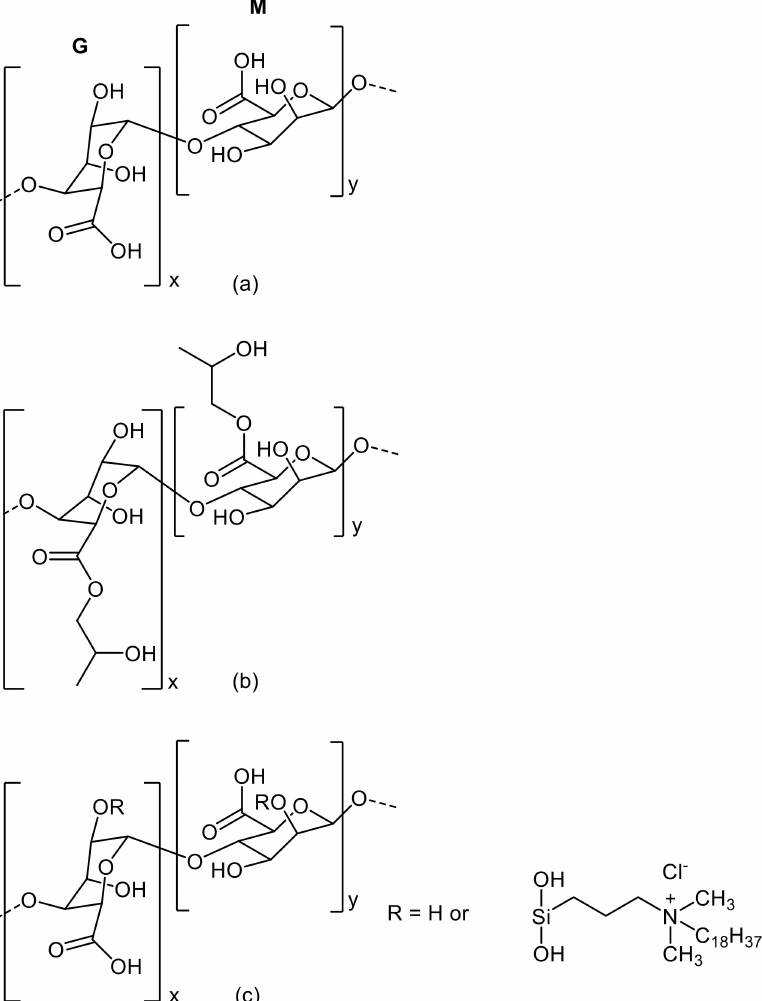
Figure 2. ( a ) Alginic acid block co-polymer containing monomers of β - D -mannuronic acid (M) and α - L -guluronic acid (G) joined by a 1,4-glycosidic linkage. ( b ) Alginic acid esterified with propylene glycol to give propylene glycol alginate (PGA) (esterification (70%) occurs at both the M and G residues. ( c ) Alginic acid reacted with (3-(trimethoxysilyl)propyl)-octadecyldimethylammonium chloride (TSA) to give the corresponding quaternary ammonium salt (ALG/QA). (Note c shows the TSA anchored at one OH group on the alginate but it could potentially react with more than one alginate OH